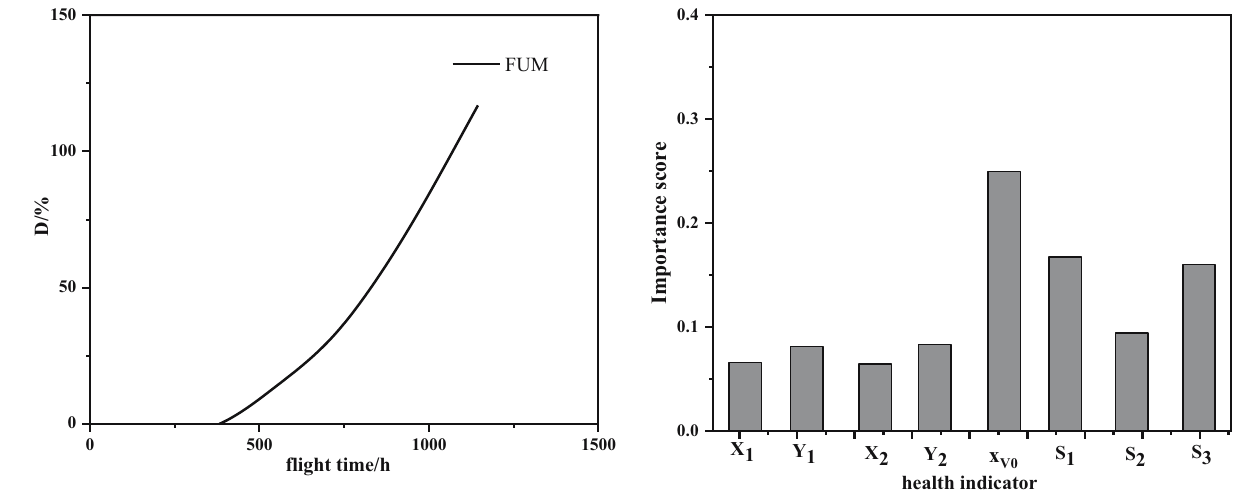
Figure 3: FMU performance degradation curve.